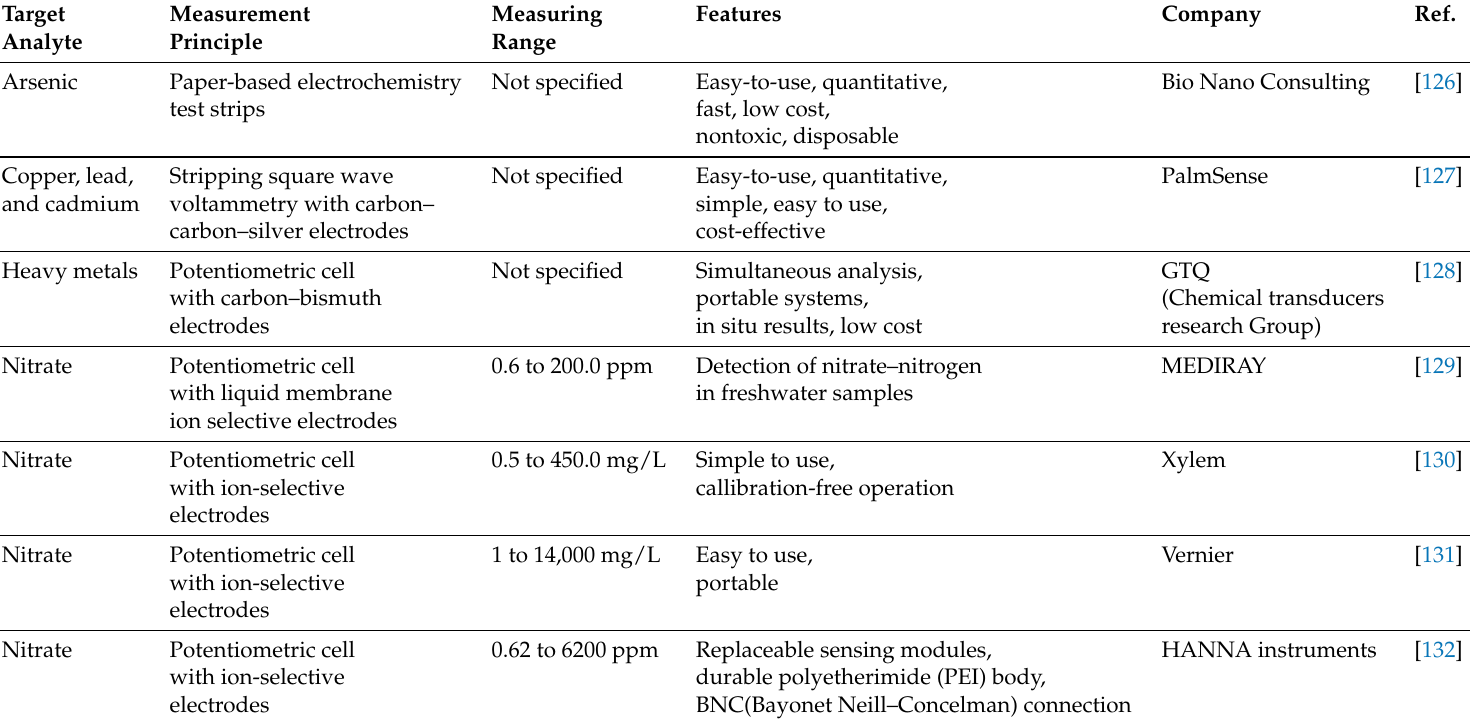
Table 3. Commercially available electrochemical